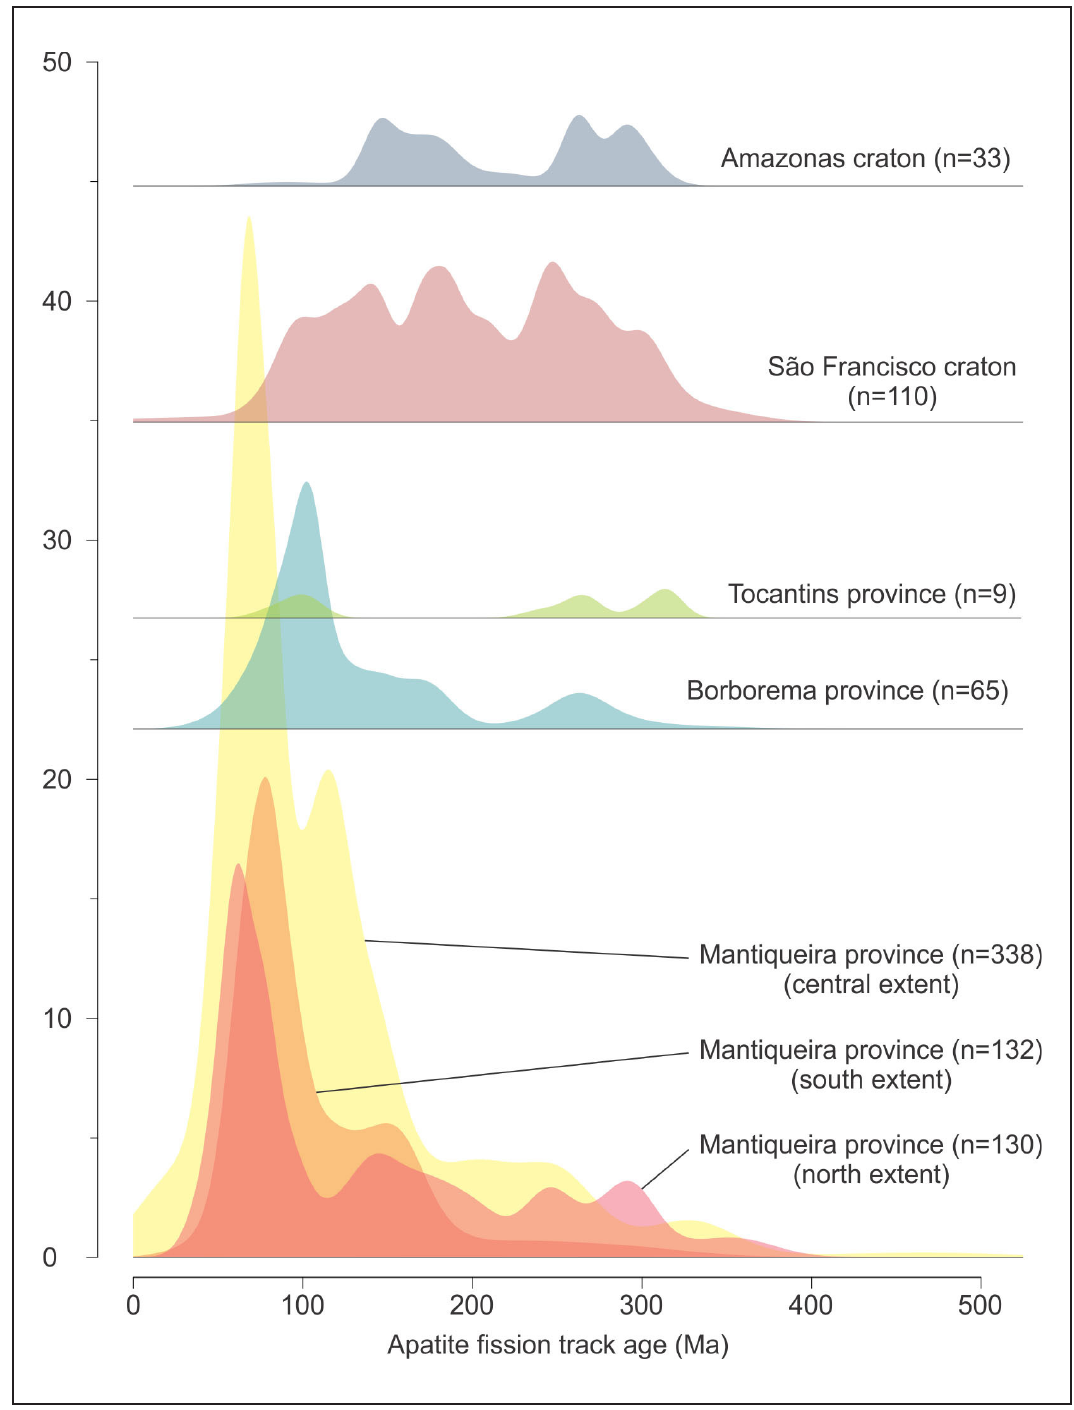
FIGURE 9 . Apatite fission-track samples dating histograms for Brazilian tectonic domains. Due to a large amount of data, Mantiqueira province was divided into three sectors: North (13ºS to 20ºS), Central (20ºS to 26 ºS), and South (26ºS to 33